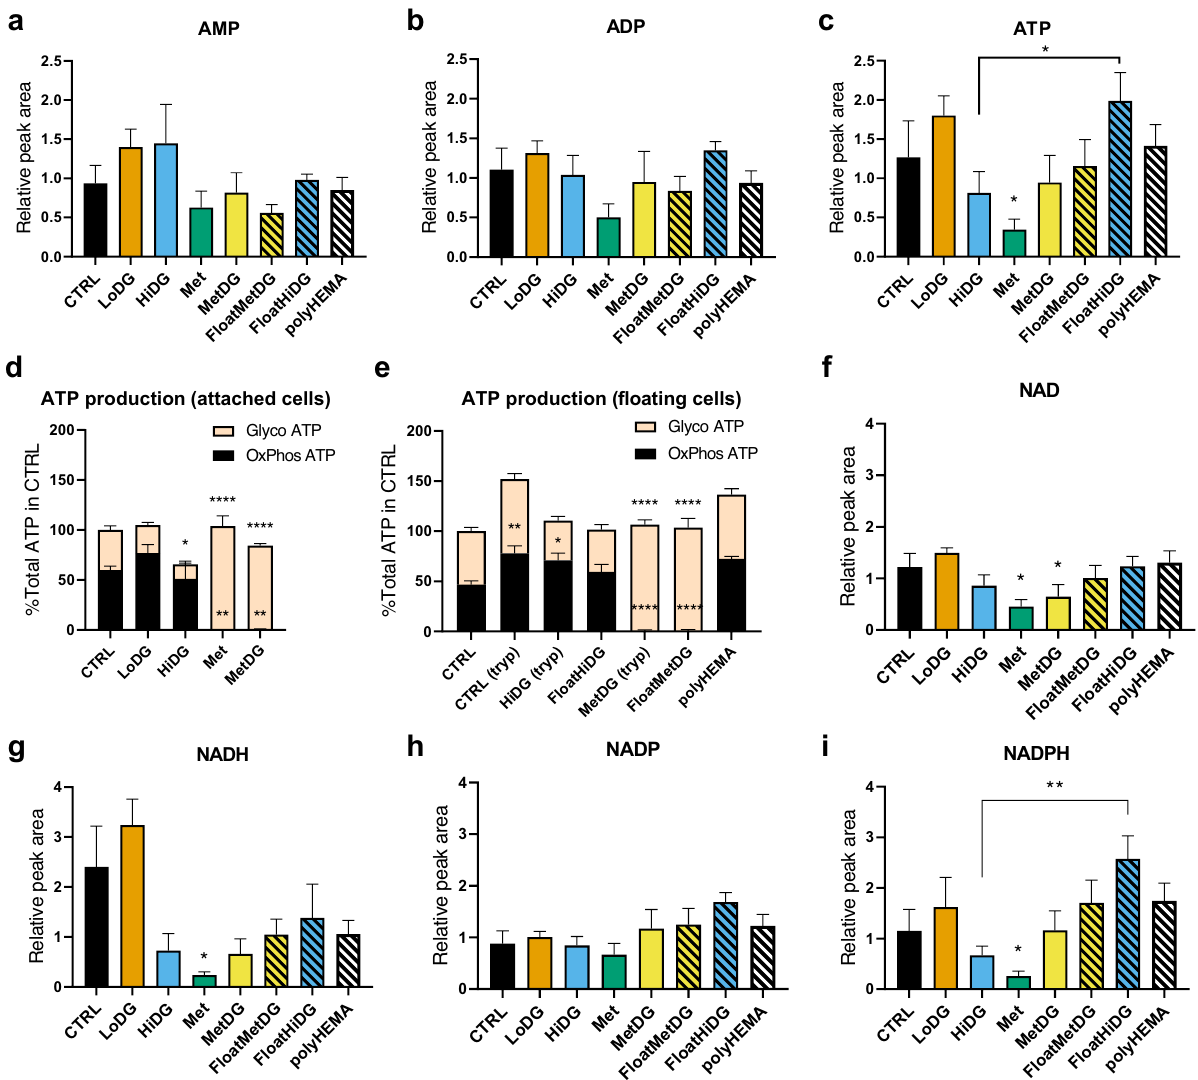
Figure 6. Energy and redox metabolism in MDA-MB-231. Mean relative QC-normalized metabolite peak areas of adenosine phosphates ( a-c ) and redox cofactors ( f–i ) ± SEM are shown from metabolic profiling. ( d, e ) MDA-MB-231 cells were treated for 48 h as indicated. Following treatment, extracellular acidification and oxygen consumption rate were measured and ATP production was obtained according to Seahorse Real-Time ATP Rate Assay protocol. Results are normalized to total ATP production in attached control cells. The mean ± SEM of 3 ( d ) or 4 (2 for poly-HEMA, ( e )) independent experiments is shown. Please note y-axis scales are different between the plots. * p < 0.05, ** p < 0.01. *** p < 0.001, **** p < 0.0001 versus CTRL unless otherwise indicated. In ( d ) and ( e ), significance is marked separately for glycolytic and OxPhos ATP